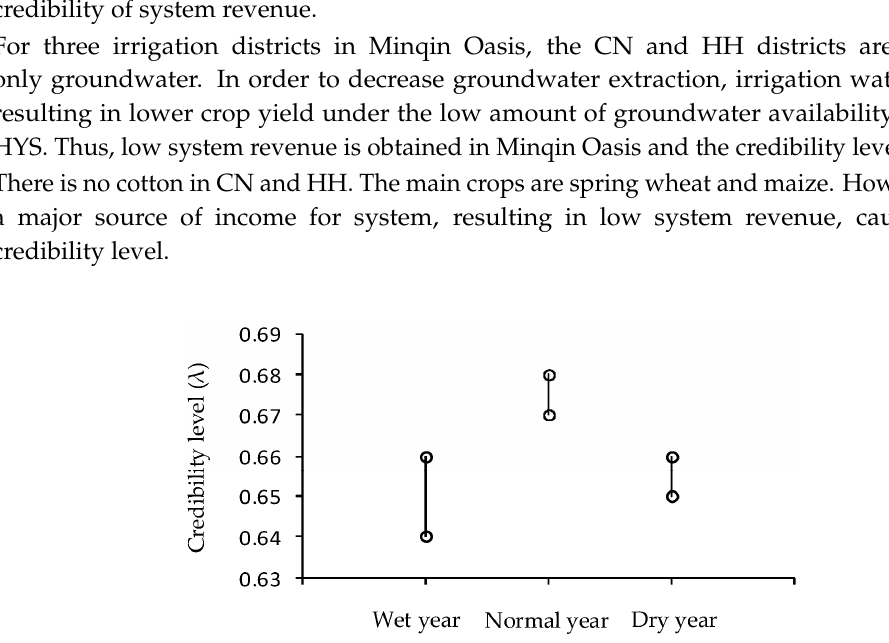
Figure 8. Credibility level of system revenue in different scenarios in Minqin Oasis.